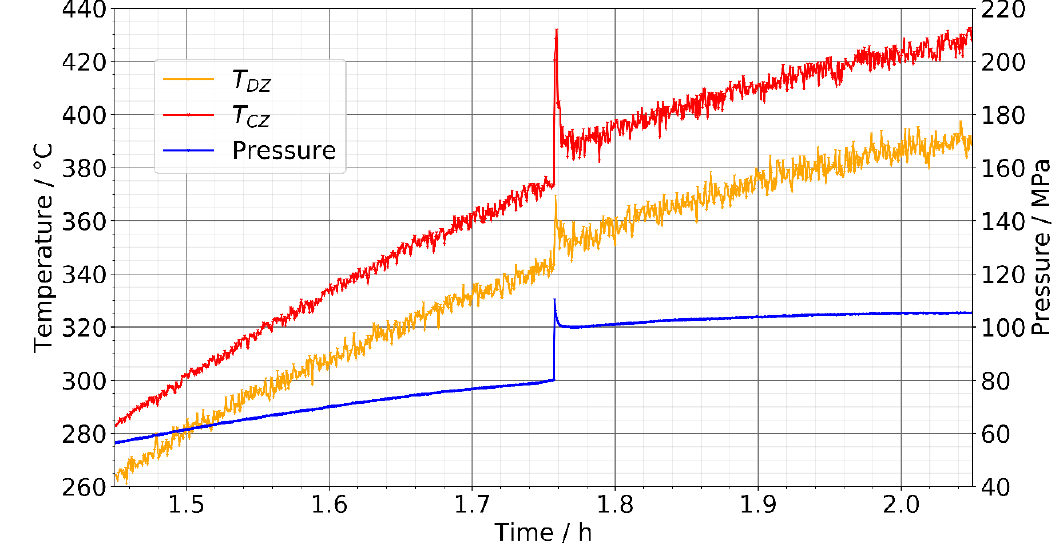
Figure 10. Close-up showing details of the sudden decomposition of NaN 3 (event ③ in Figure 9). Note the increase in the bandwidth of temperature fluctuations after azide decomposition.